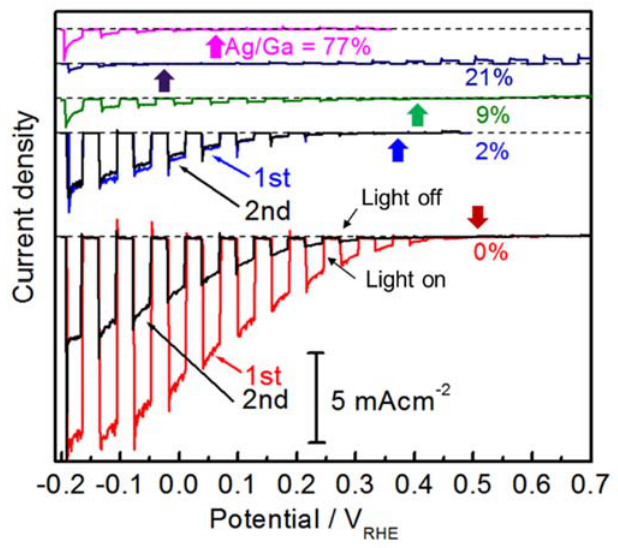
Figure 7. Current-potential curves for Pt/AGSe electrodes with various Ag/Ga ratios. A 0.1 M aqueous Na 2 SO 4 solution (adjusted to pH 9 by NaOH addition) was employed as the electrolyte. Onsets of cathodic photocurrents are pointed out by